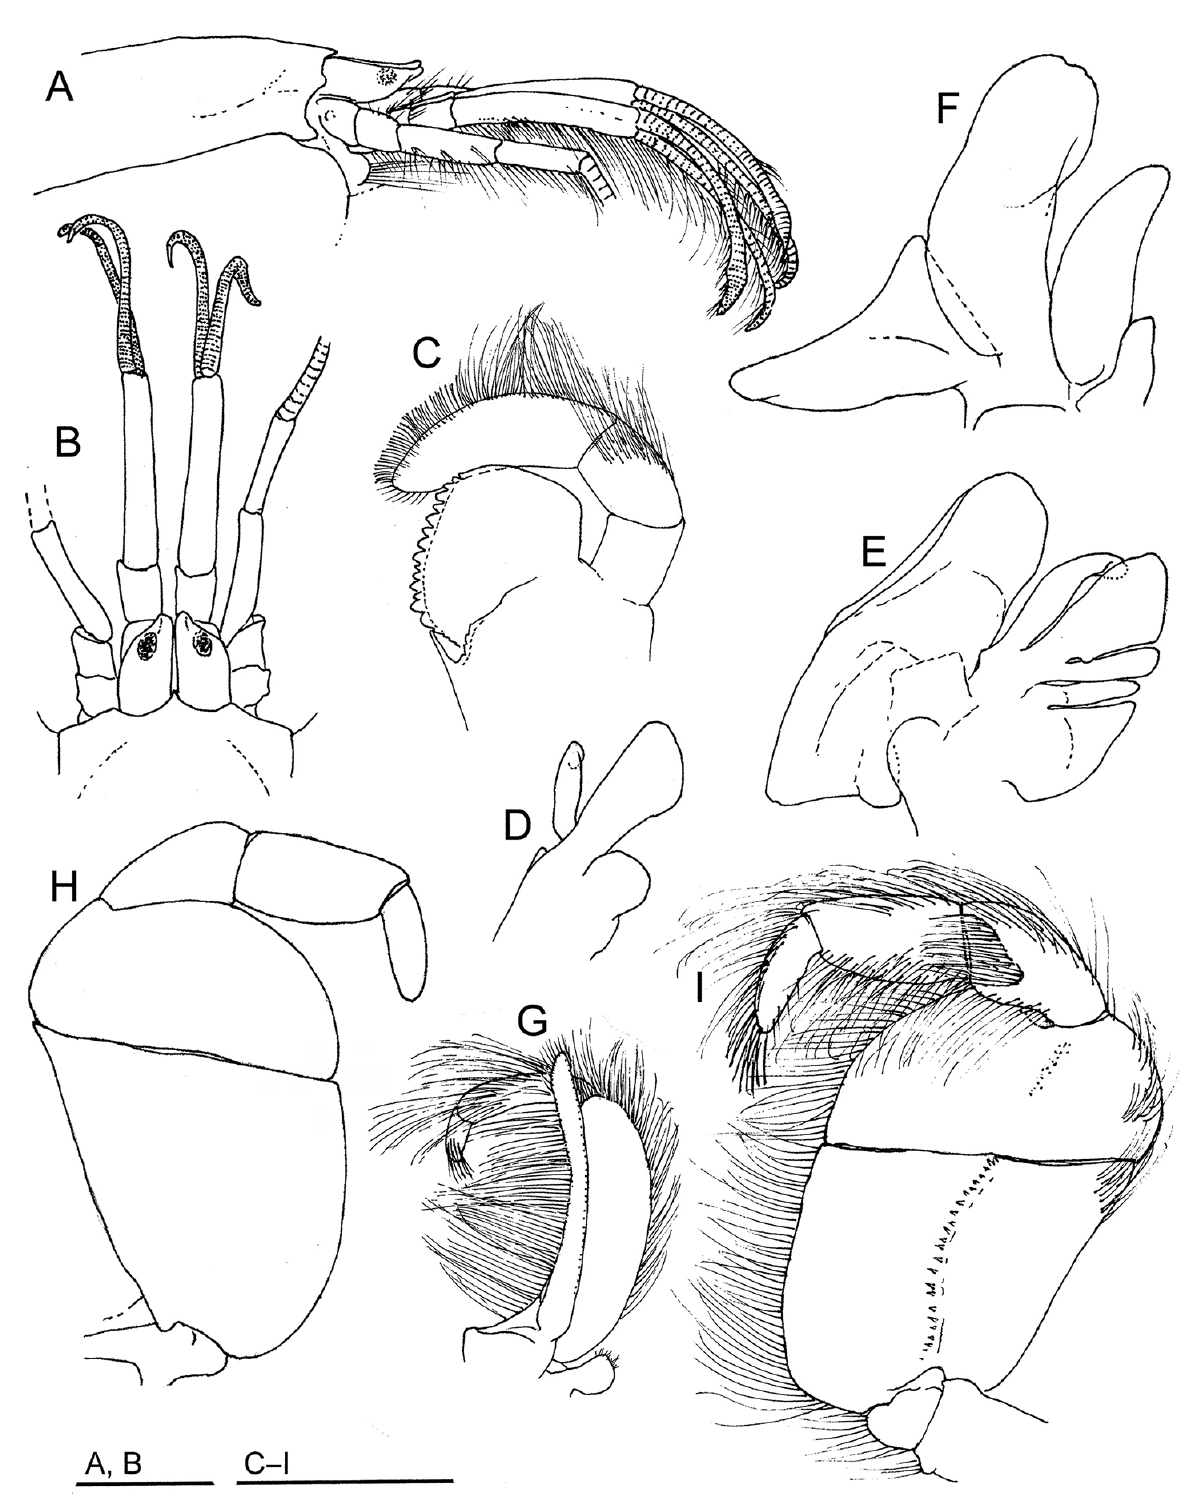
Figure 2. Gilvossius howellorum n. sp., male holotype, pocl 12.4 mm, lower Tampa Bay, St. Petersburg, Florida, shallow subtidal flat (USNM 1546234 = ULLZ 12183): A, B , anterior carapace, eyes, and peduncles, lateral and dorsal; C , right mandible, internal; D , right first maxilla, external; E , right second maxilla, external; F , right first maxilliped, external; G , right second maxilliped, internal; H , right third maxilliped without setae, external; I , right third maxilliped, internal. Scale bars = 3.0 mm ( A, B, D–I ), 1.5 mm ( C